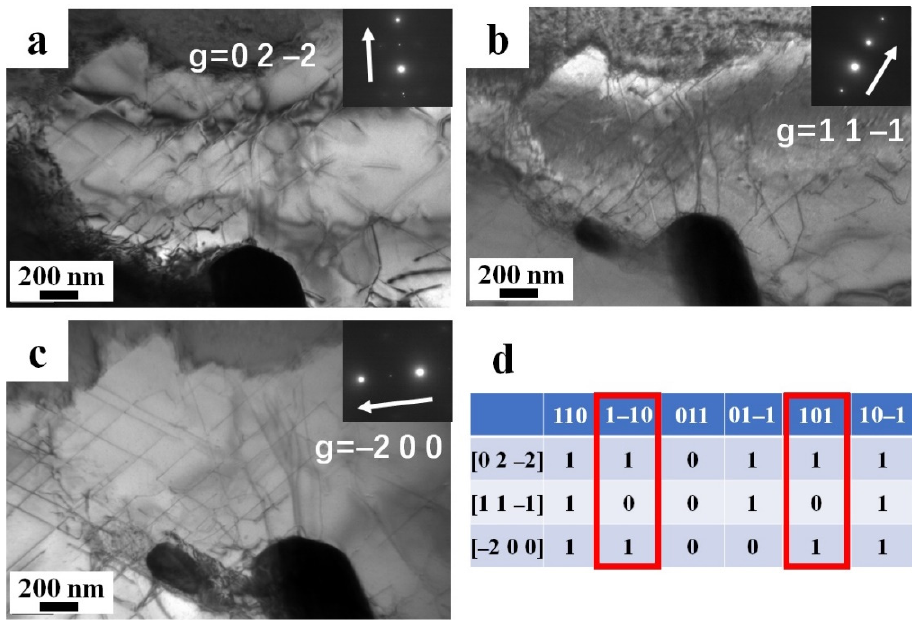
Figure 8. Enlarged TEM image of Area_1 in Figure 6, which is 10 mm away from the fracture surface ( a ) diffraction pattern; bright field TEM image with ( b ) g = [0 2 − 2]; ( c ) g = [1 1 − 1]; ( d ) [ − 2 0 0].